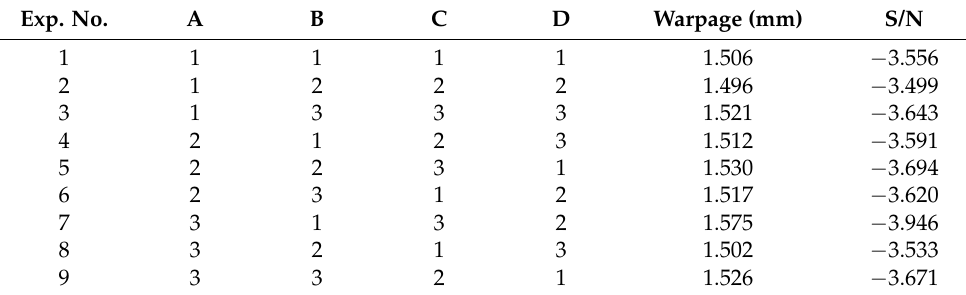
Table 6. Warpage results and corresponding S/N ratios. Exp. No.